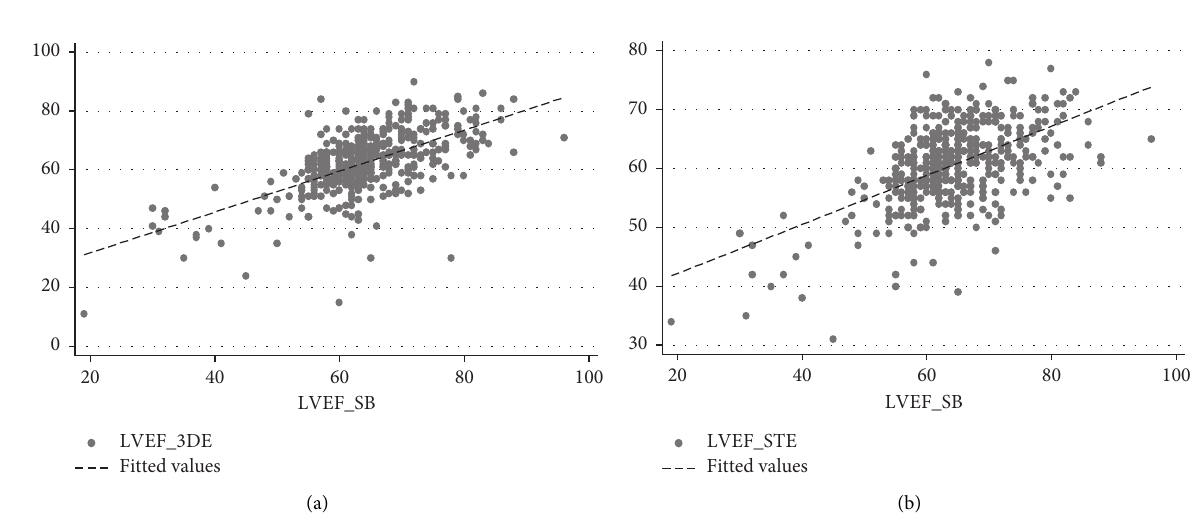
Figure 2: Simple linear regression analysis between LVEF_3DE and LVEF_SB (a) and LVEF_STE and LVEF_SB (b). LVEF_3DE � 17.92+0.69 LVEF_SB. LVEF_STE � 33.84+0.42